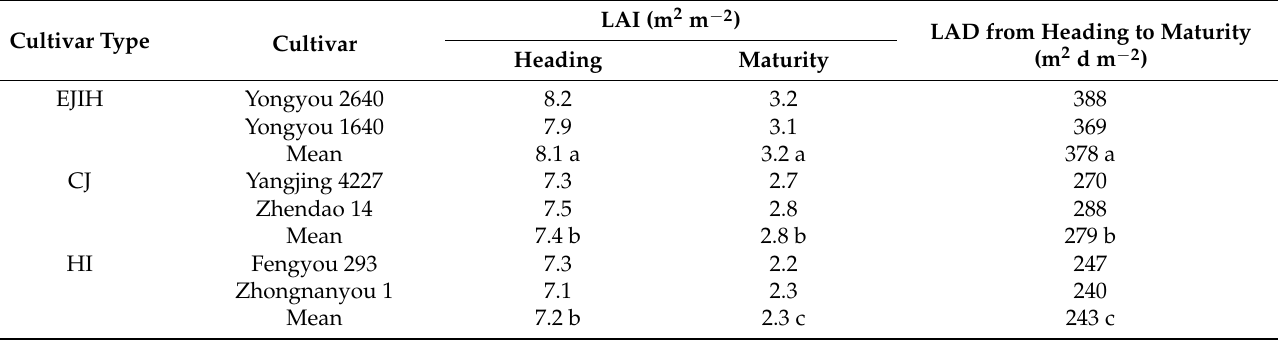
Table 7. LAI and LAD after heading of rice